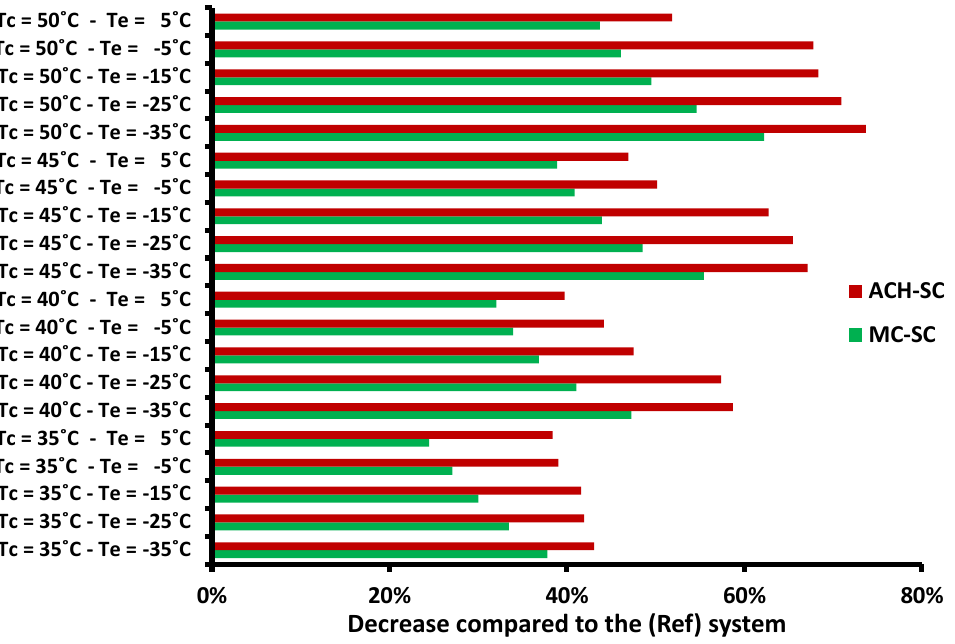
Figure 20. Work consumption decrease with the subcooling cases compared to the reference case in all the examined optimized scenarios. Table 2. Work and the heat input demand for the examined operating scenarios for all the three examined refrigeration systems.